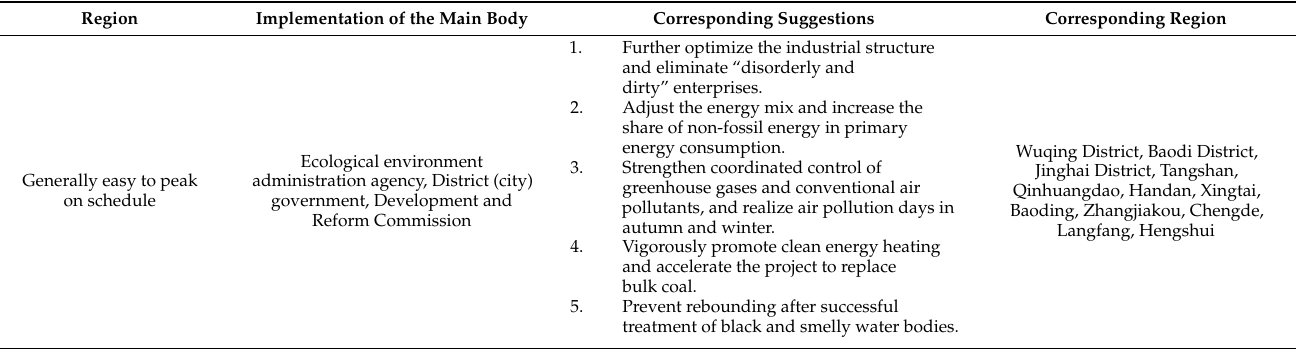
Table 5. Recommendations for areas that are generally easy to achieve peak carbon on